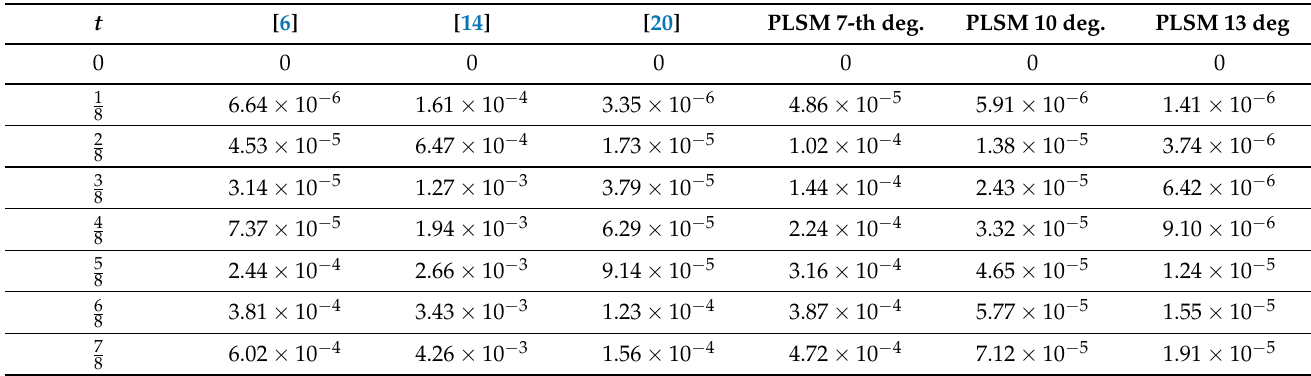
Table 2. Comparison of the absolute errors of the approximate solutions for problem